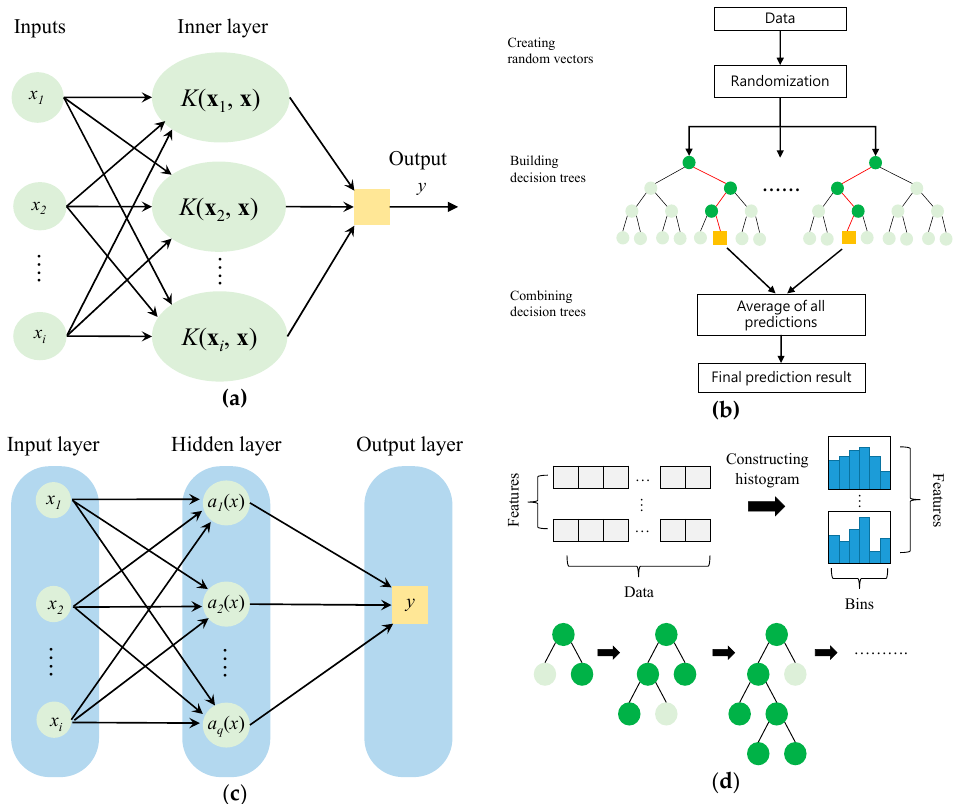
Figure 1. The conceptual diagram for ( a ) support vector regression (SVR), ( b ) random forest regression (RFR), ( c ) multilayer perceptron regression (MLPR), and ( d ) light gradient boosting machine regression (LGBMR).